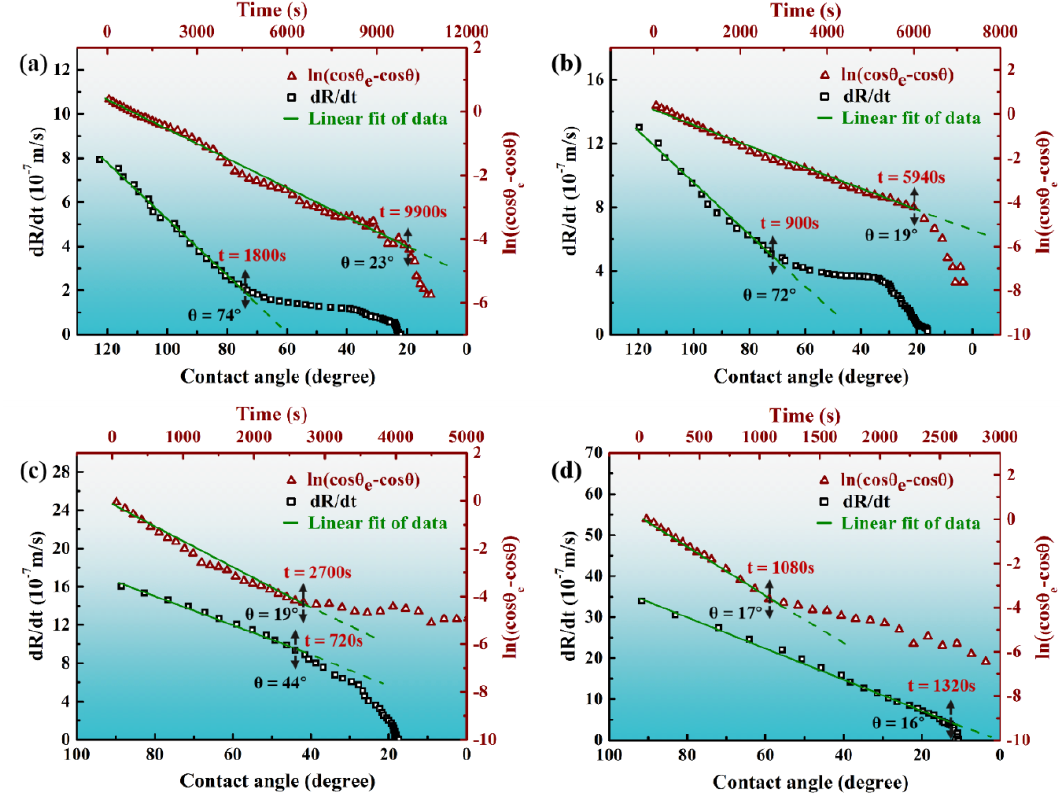
Figure 8. Plots of spreading rate ( dR/dt ) against contact angles and ln(cosθ e - cosθ) values of Sn-3V alloy on porous graphite against isothermal dwell time at ( a ) 750 °C, ( b ) 800 °C, ( c ) 850 °C, and ( d ) 900